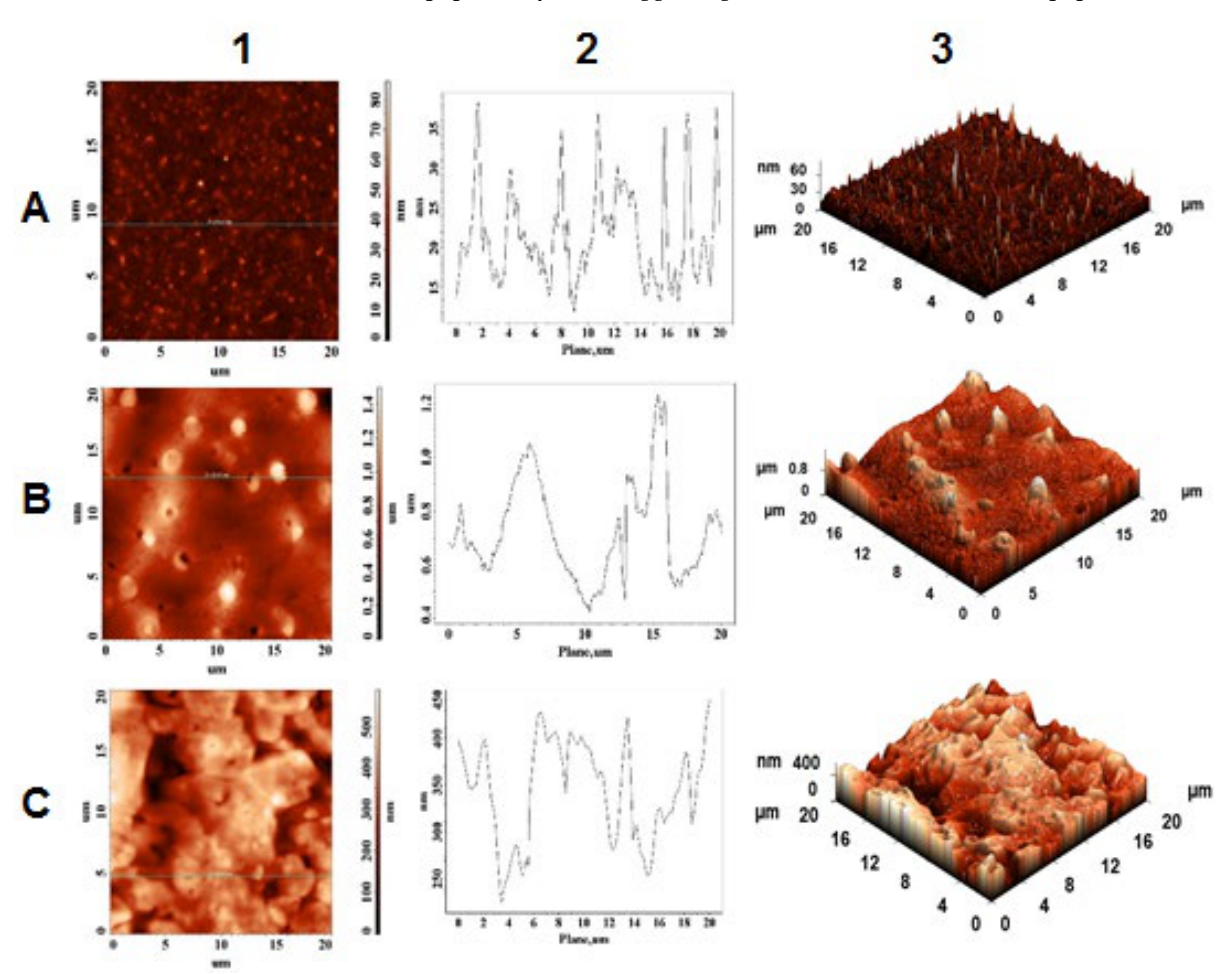
Figure 10. AFM images of Abeta9-16 peptide ( A ); in the presence of copper ions ( B ) and zinc ions ( C ); (1) height of AFM images; (2) plot height distribution of particles along the profile line; and (3) 3D AFM images.